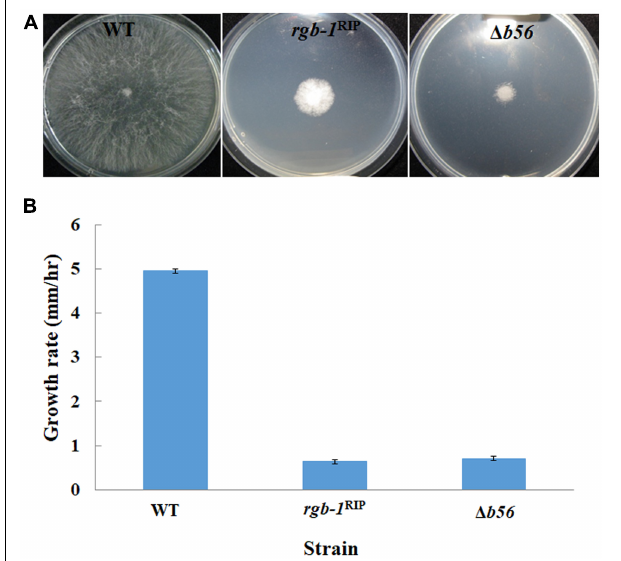
FIGURE 2 | Colony morphology and growth rates of wt, rgb-1 , and b56 regulatory subunit-encoding gene mutants. (A) Colony growth of the wt, rgb-1 RIP , and (cid:49) b56 strains grown on VgS medium at 34 ◦ C for 20 h. (B) Growth rate of the wt, rgb-1 RIP , and (cid:49) b56 grown in race tubes at 34 ◦ C. Bars indicate standard